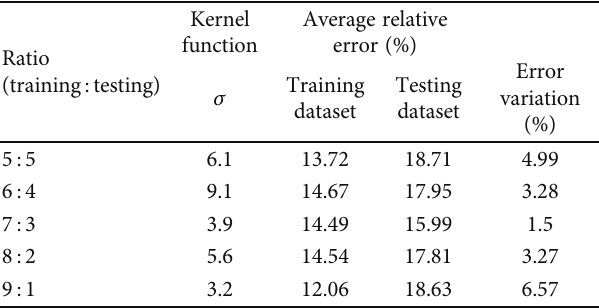
Figure 14: Optimization process of kernel function under di ff erent data proportions. Table 2: Kernel function optimization results and error statistics of KELM method under various data